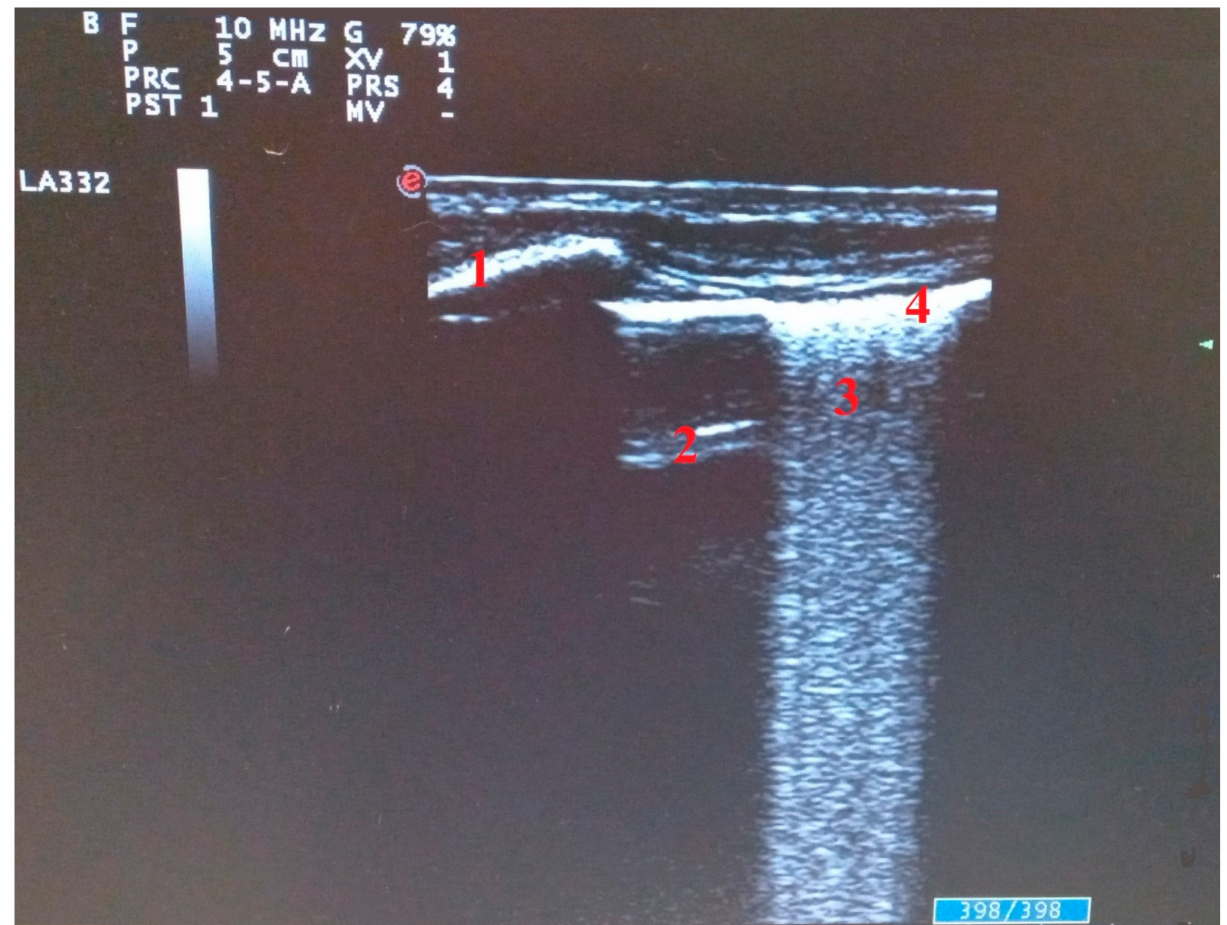
Figure 2. Ultrasound findings in SARS-CoV-2 pneumonia: (1) ribs, (2) A line, (3) cluster of B lines, (4) pleural line. The Kerley B-lines visible on chest X-ray, which are the expression of the thickening